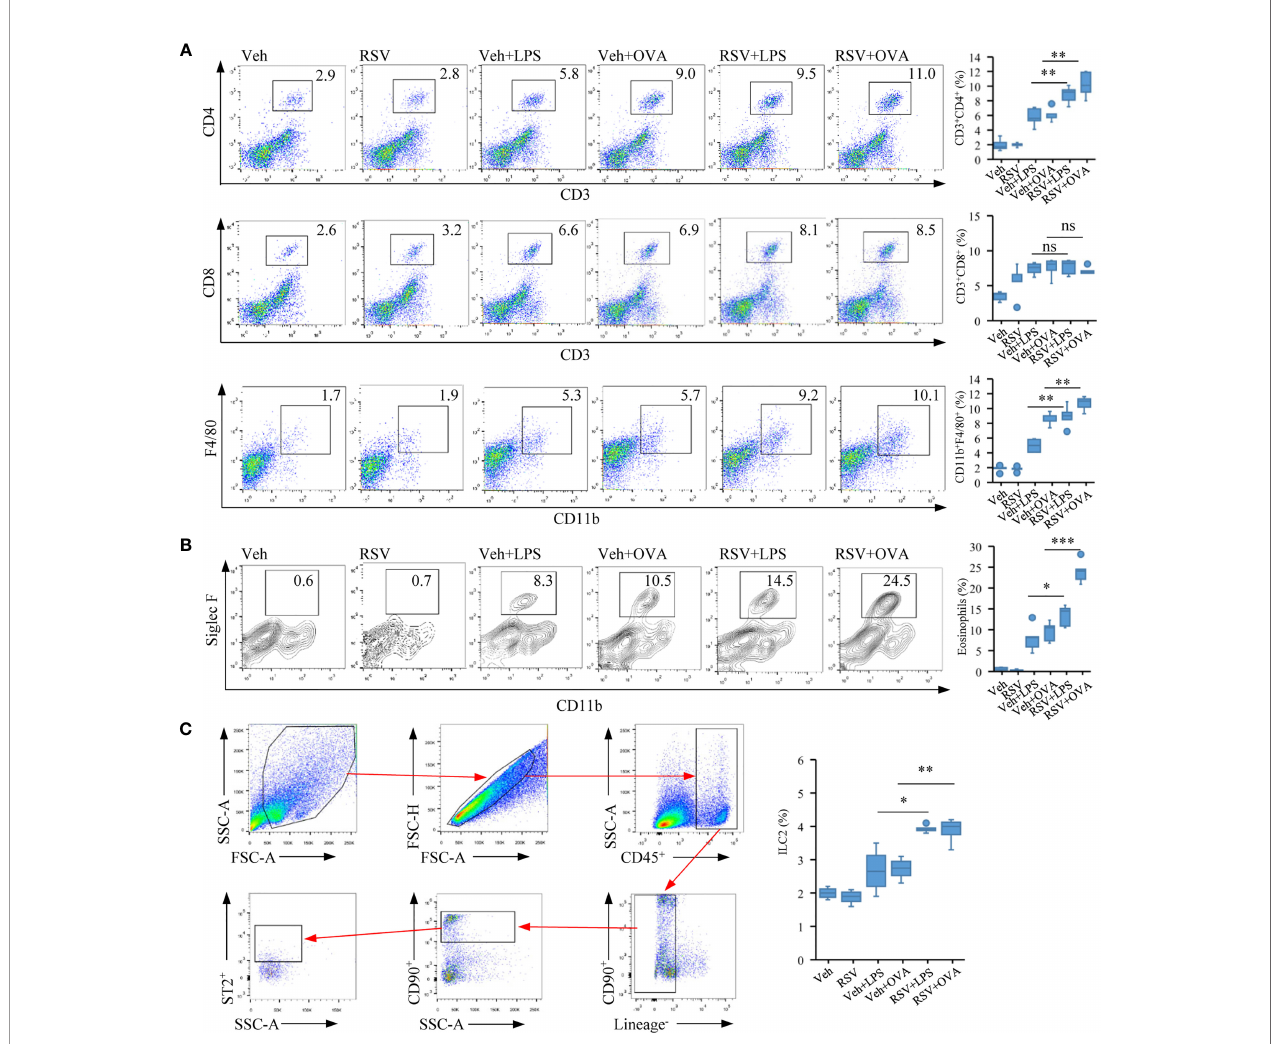
FIGURE 2 | Early-life RSV infection predisposes eosinophil accumulation and allergic immune response. (A) Representative staining of CD4 + T (CD3 + CD4 + ), CD8 + T (CD3 + CD8 + ) andmacrophage (F4/80 + CD11b + ) in the lungtissues by fl ow cytometryanalysis ( n = 5). (B) Representative staining ofeosinophilcells (CD11c − CD11b + SiglecF + ) inthe lungtissues by fl ow cytometry analysis ( n = 5). (C) Gating strategyfor ILC2 cells (CD45 + CD90.2 + ST2 + Lineage − ). Quanti fi cation ofCD4 + T, CD8 + T, macrophage, eosinophil, and ILC2 cellpopulationsare presented ( n = 5). The statistical box plots are shown:ns, nosigni fi cance; * p < 0.05, ** p < 0.01, and *** p <